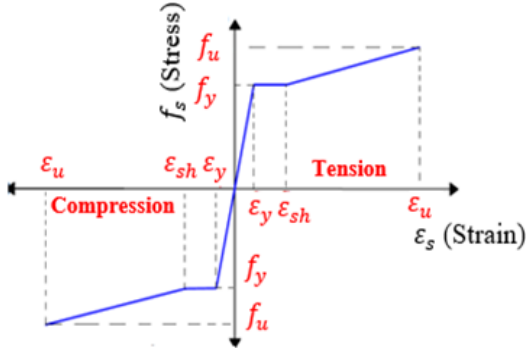
Figure 6. Steel Stress–Strain Curve [39,40].